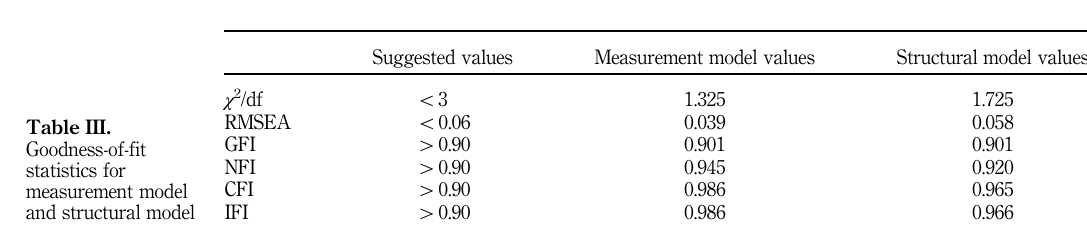
Table III. Goodness-of-fit statistics for measurement model and structural